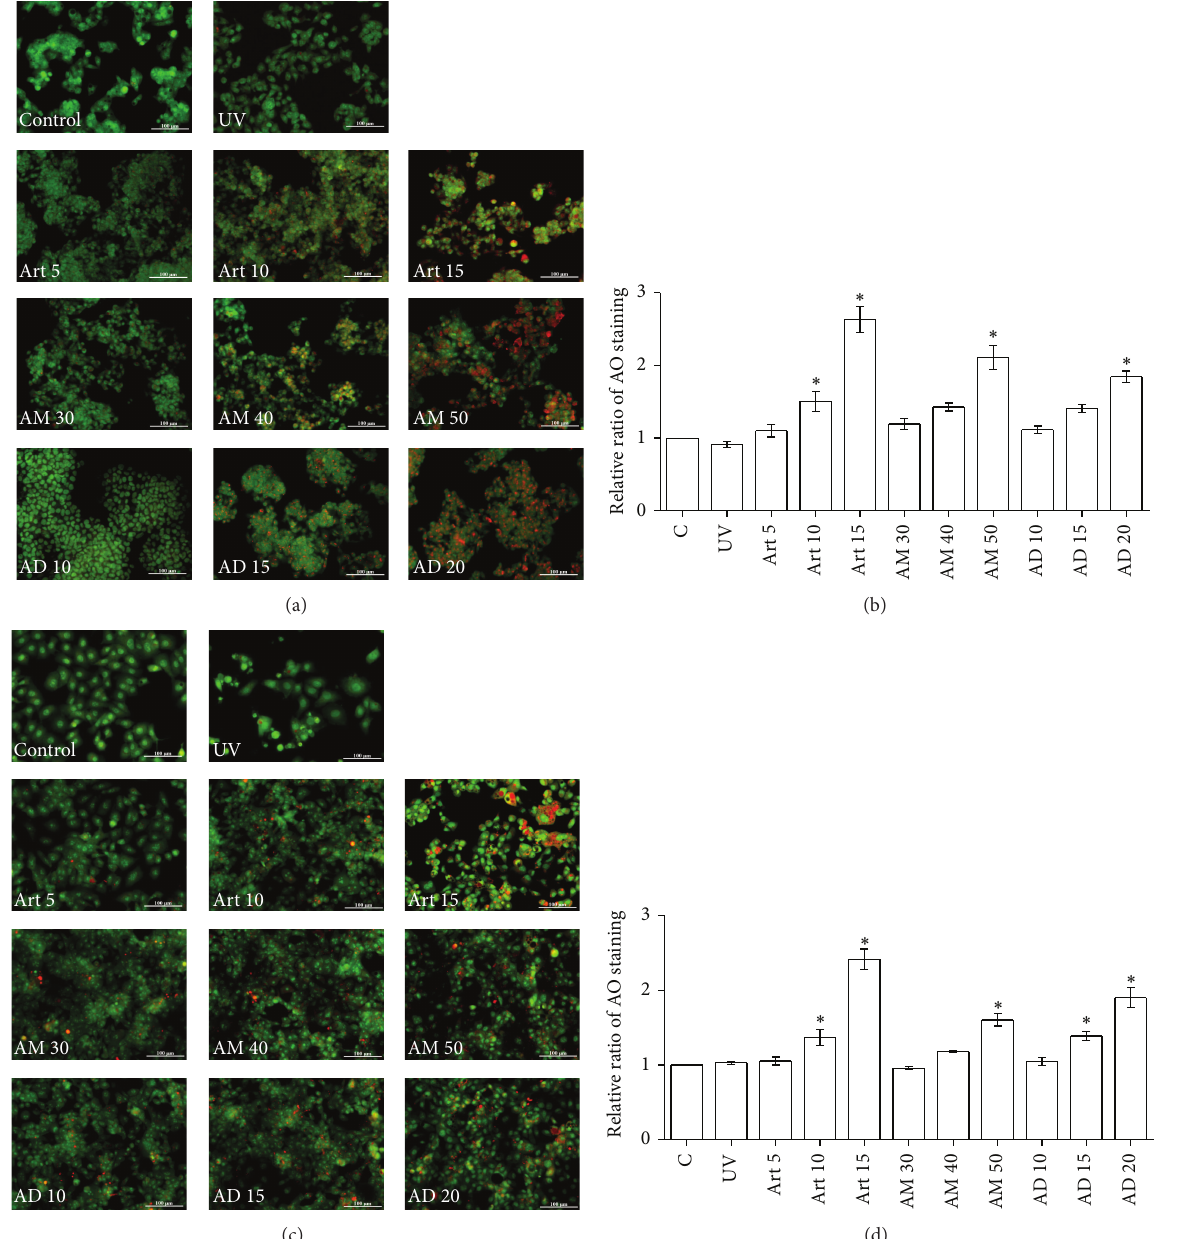
Figure 4: A. communis extracts AM and AD induced autophagy in HepG2 and PLC/PRF/5 cells. (a) HepG2 and (c) PLC/PRF/5 cells were treated with Art, AM, or AD for 24 h or UV for 10min. Then, cells were stained with 5 𝜇 g/mL of acridine orange (AO) for 15 min. The autophagic vacuoles were visualized by fluorescence microscopy. AO staining was quantified in control, UV, Art, AM, and AD treated HepG2 (b) and PLC/PRF/5 (d) cells for different concentrations. Art: artocarpin; AM: methanol extract; AD: dichloromethane fraction; UV: